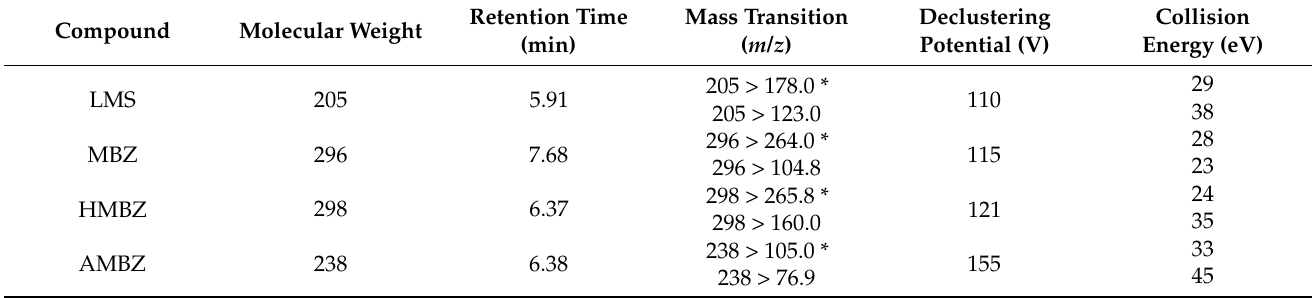
Table 3. HPLC–MS/MS conditions and retention times for LMS, MBZ, HMBZ, and AMBZ